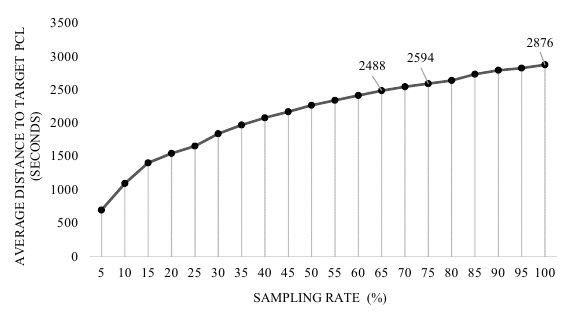
Figure 13. Impact of sampling breast PCL on the training time of RF.